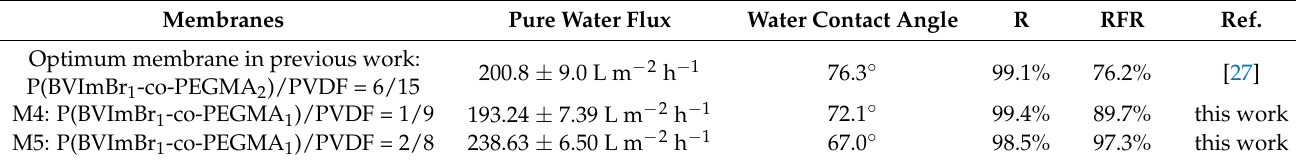
Table 4. Parameters of different membranes during the filtration of BSA solution (pH 3.6). Membranes Pure Water Flux Water Contact Angle R RFR